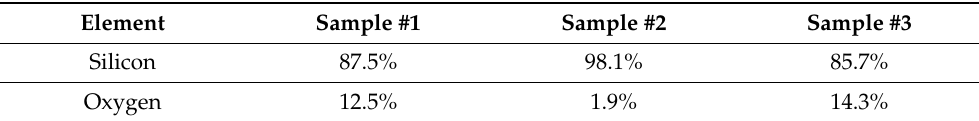
Table 2. EDX atomic composition analysis of three samples.